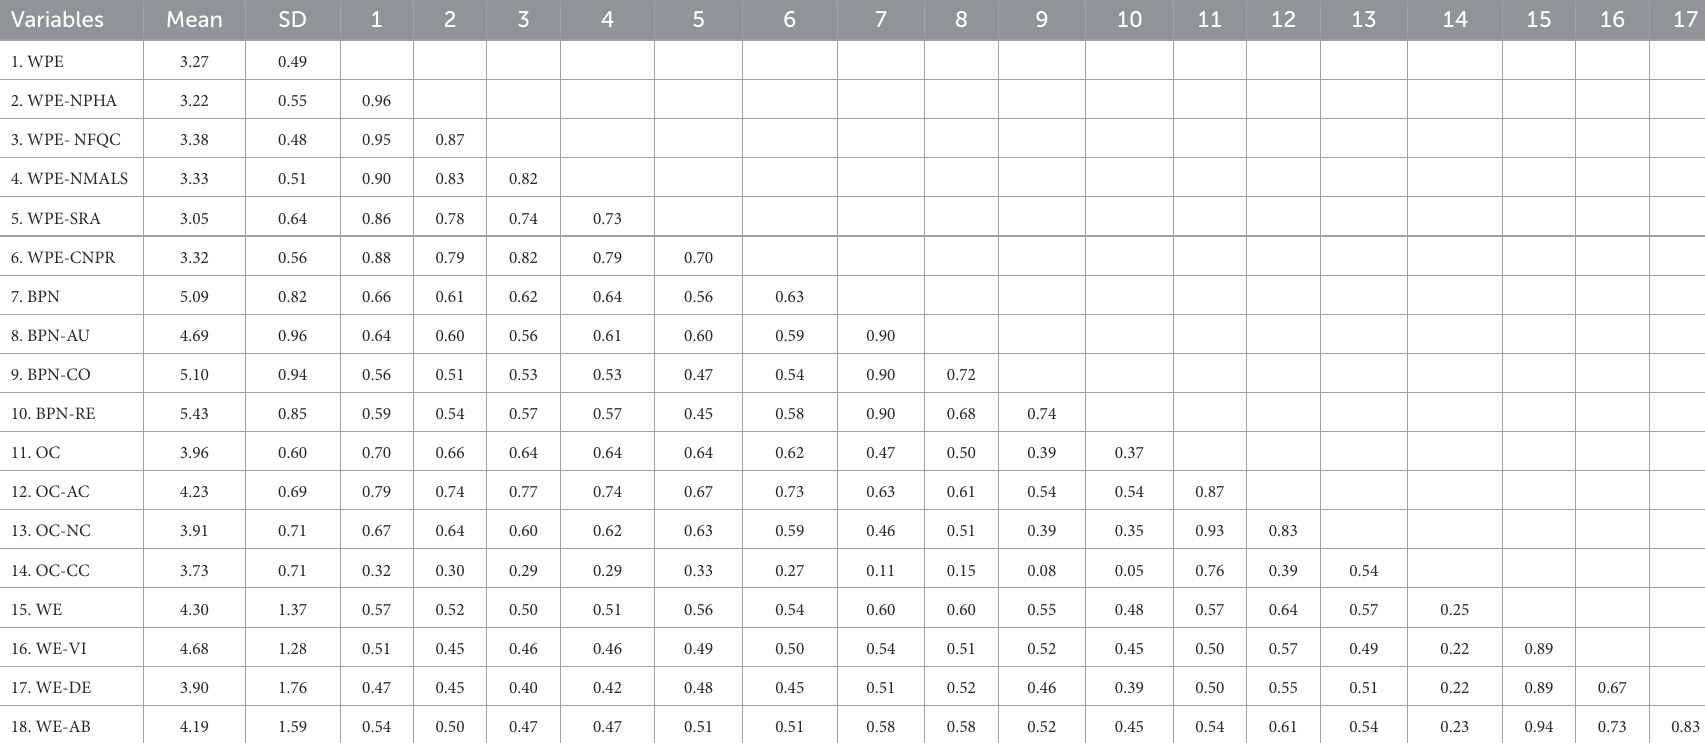
TABLE 2 Means, standard deviation, and correlations between the study variables ( N = 893).